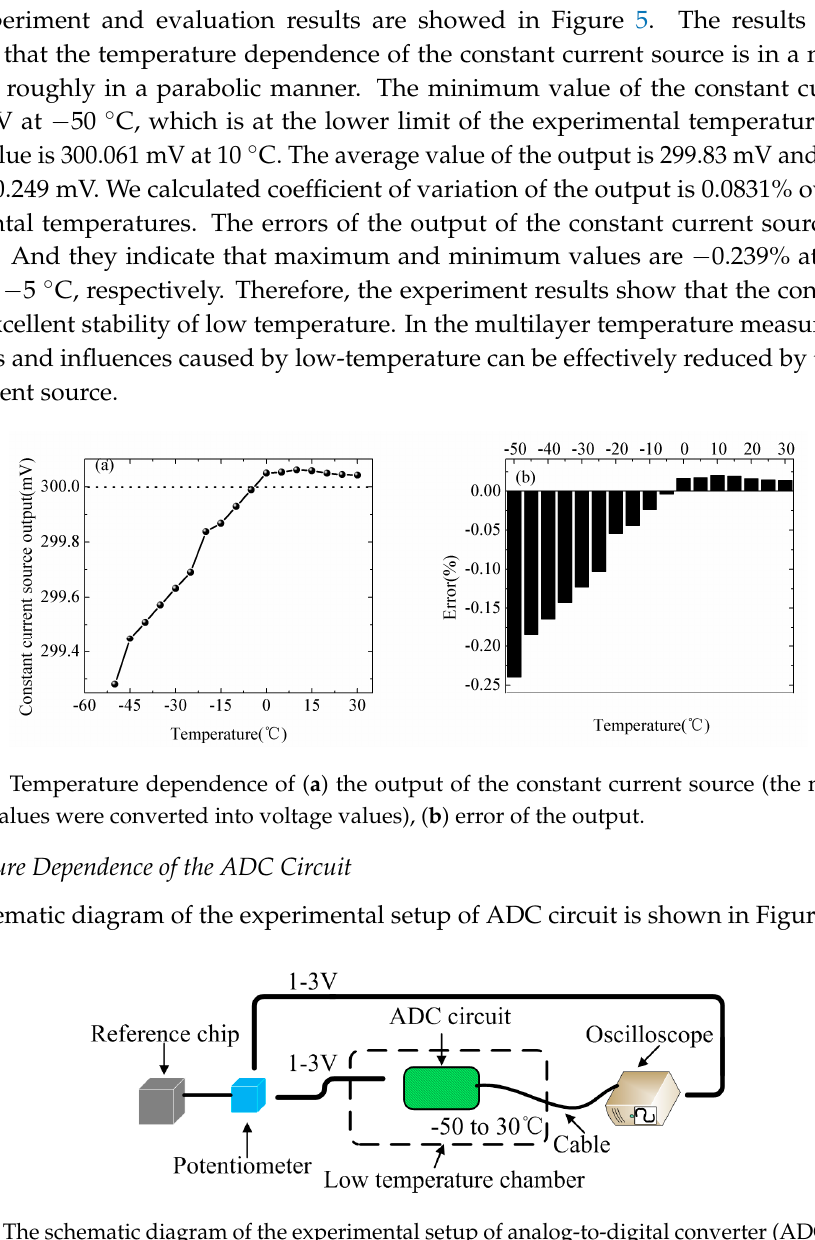
Figure 4. The schematic diagram of the experimental setup of constant current source.